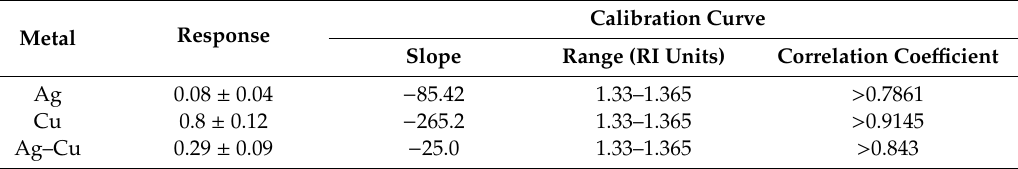
Table 6. Properties of the metal-deposited SPR optical fiber sensors with Ag, Cu, and Ag–Cu at 100% of